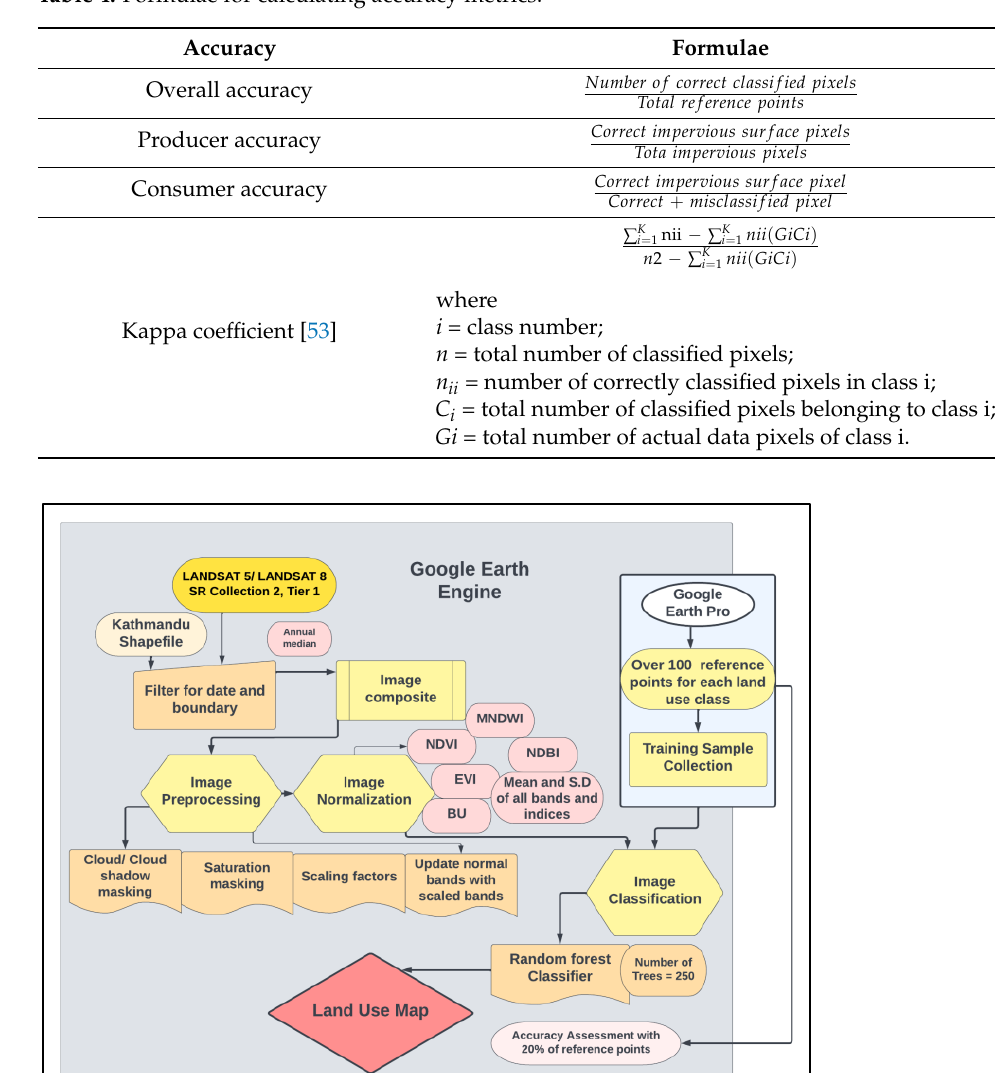
Table 4. Formulae for calculating accuracy metrics.